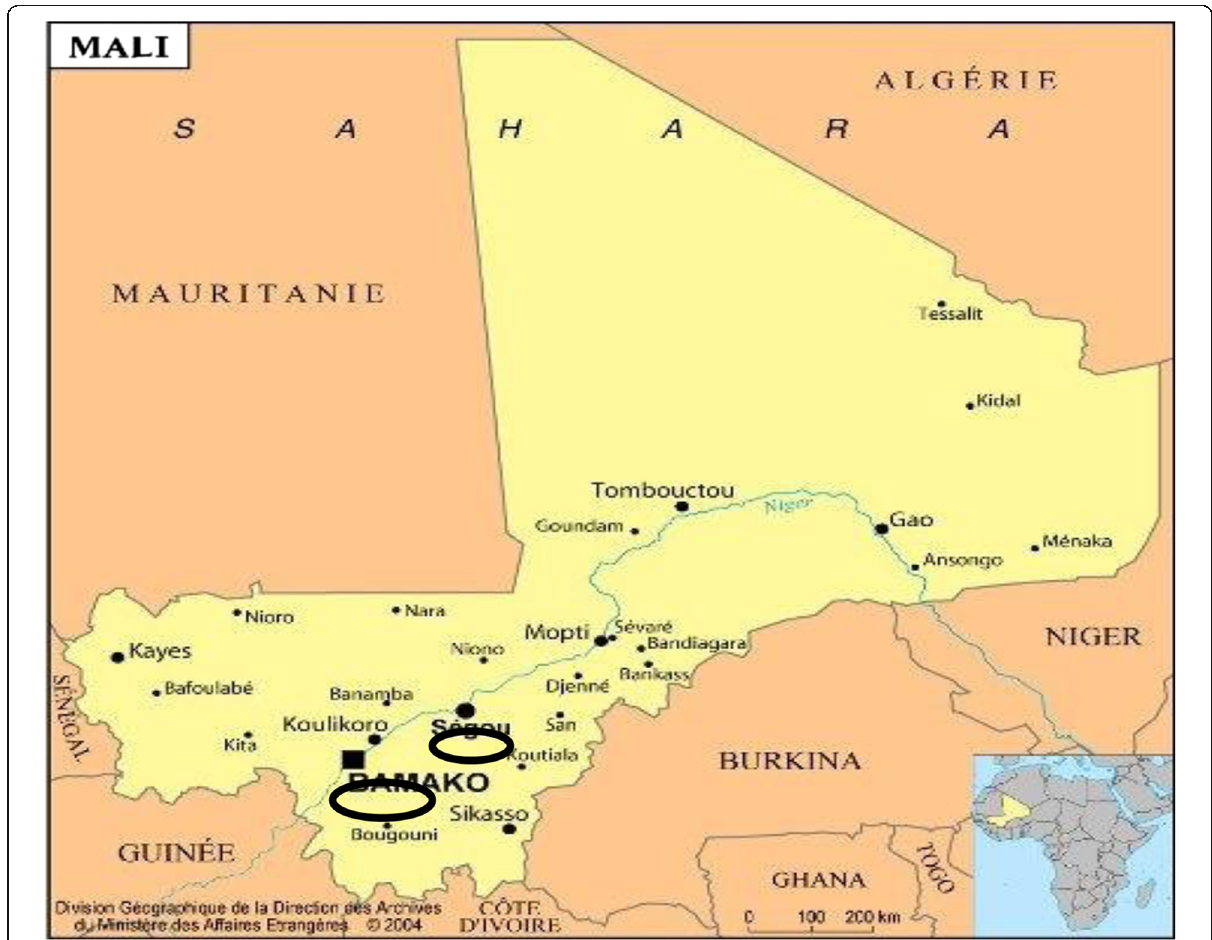
Figure 1 Map of Mali showing Bougouni and Koutiala districts, southern Mali (study